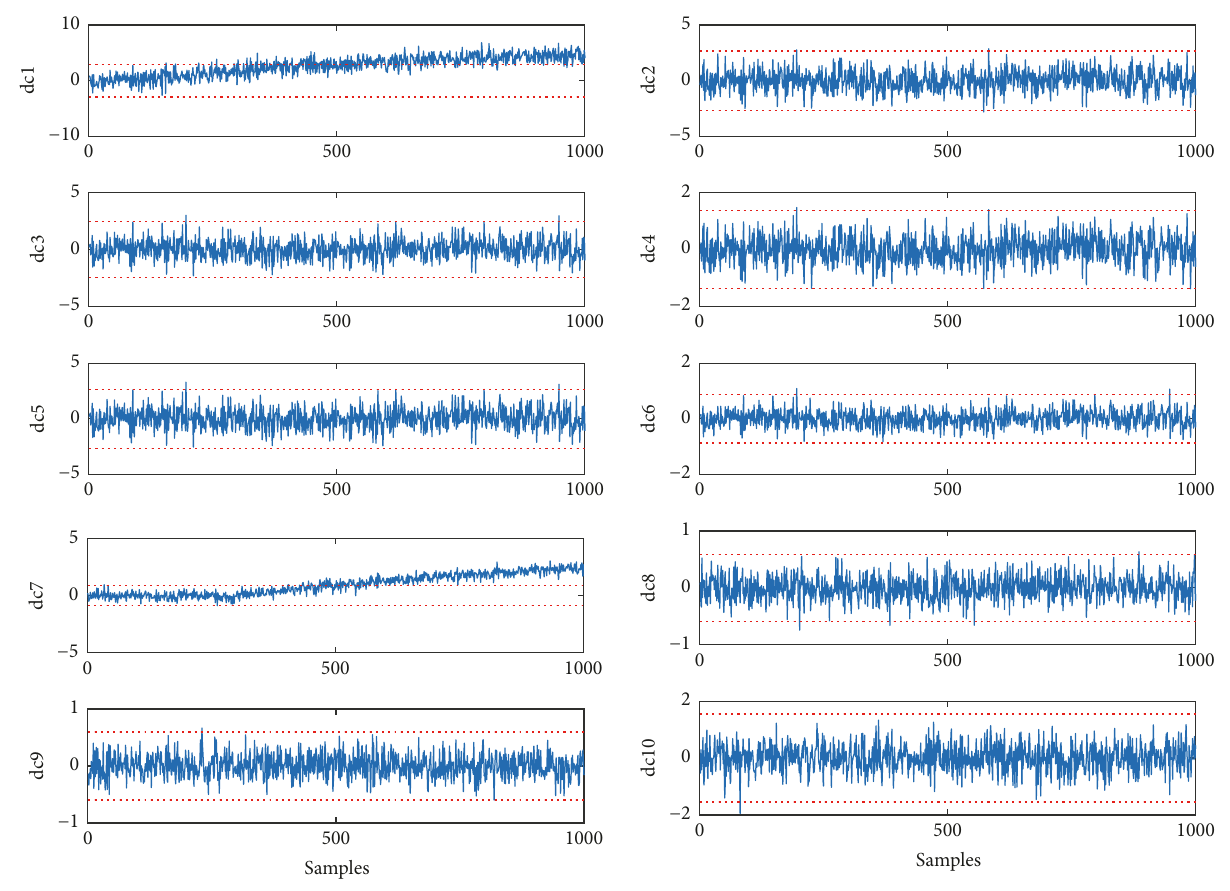
Figure 2: DCA-based faults diagnosis.